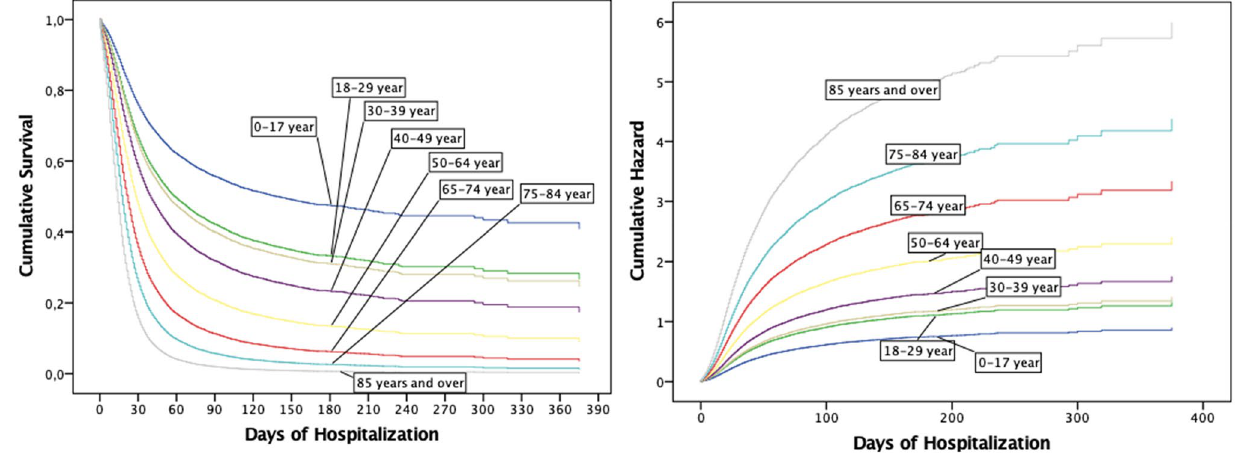
Figure 2. Cumulative survival (left panel) and cumulative hazard (right panel)” during Hospitalization